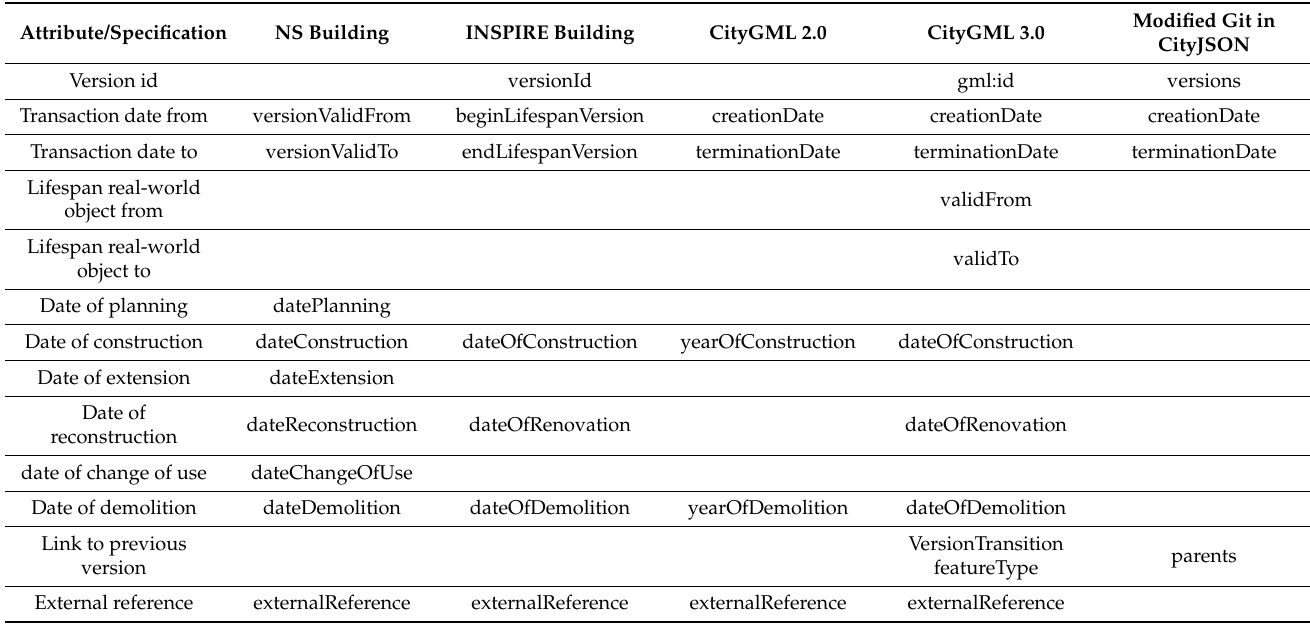
Table 2. Comparison of versioning information included in specifications NS Building, INSPIRE Building, CityGML 2.0 and 3.0, and modified Git versioning proposal implemented in